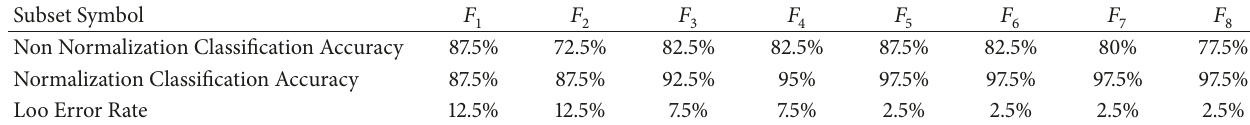
Table 5: Loo Error Rate.